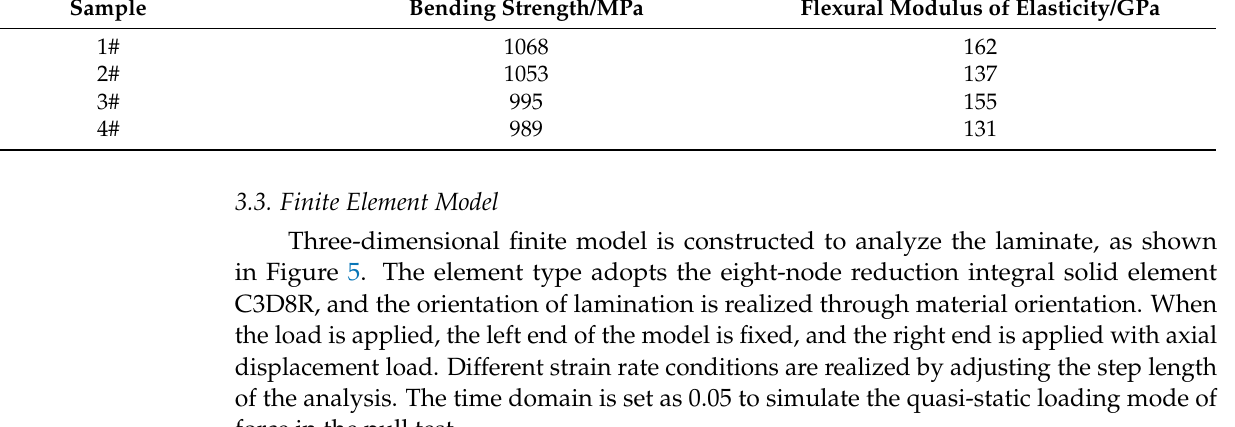
( c ) Figure 6. The maximum failure surface and depth of the specimen with different thickness: ( a ) the fourth layer, 1.25 mm, ( b ) the ninth layer, 3.25 mm, ( c ) the seventh layer, 5.10 mm.